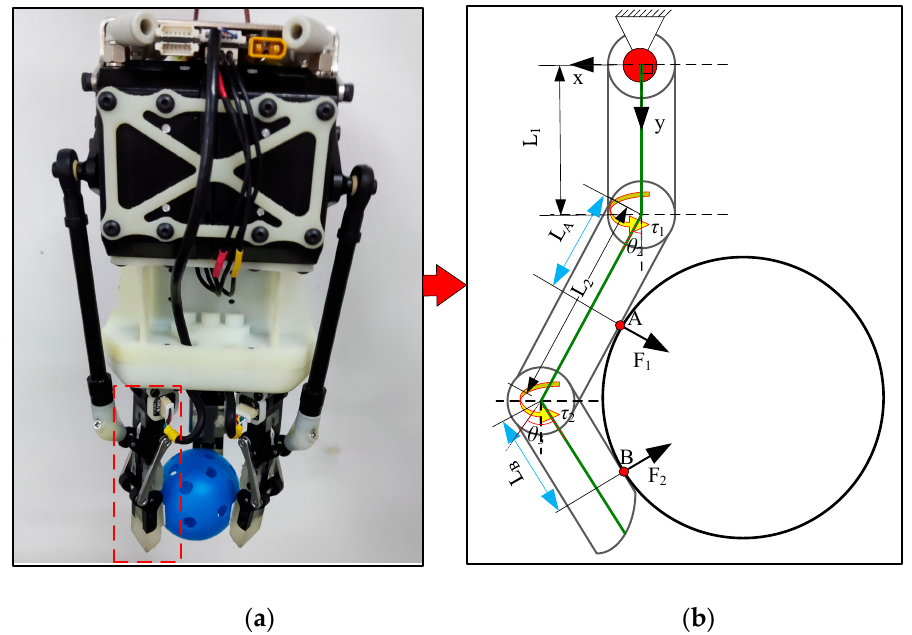
Figure 7. Schematic diagram of geometric model of gripper envelope grab. ( a ) Physical picture. ( b ) Structure diagram.